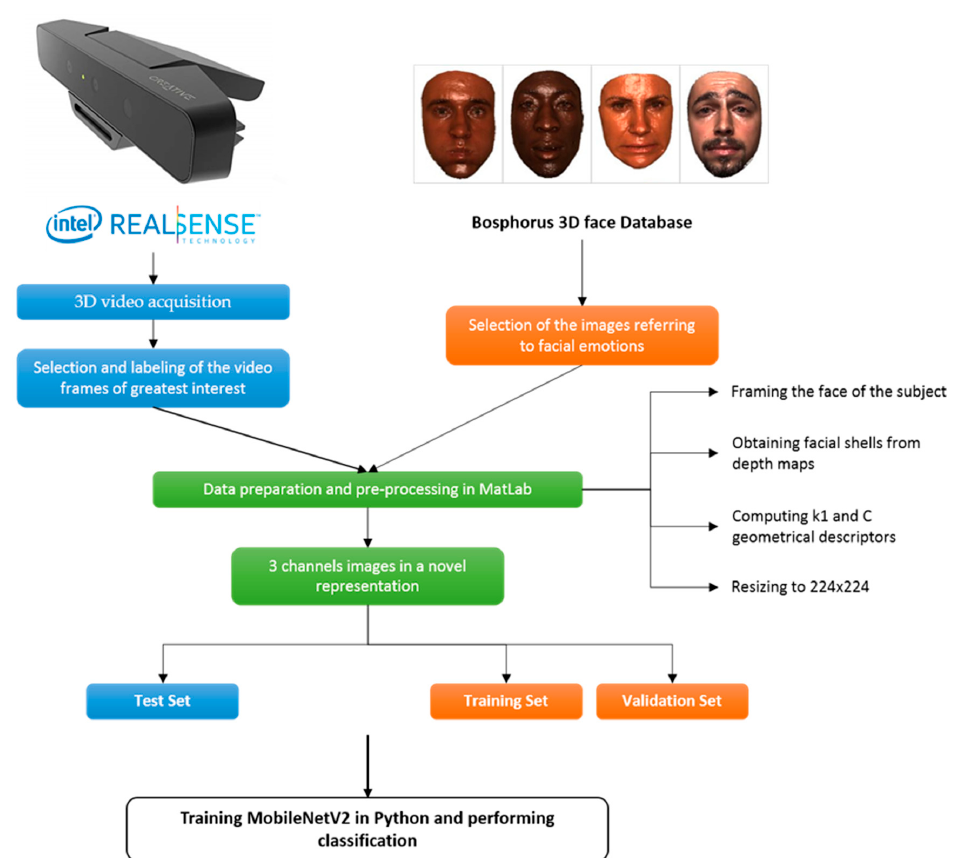
Figure 2. Scheme of the proposed methodology. Blue refers to the sensor, from acquisitions to test set, orange refers to the Bosphorus DB, and green to the common operations of data preparation and pre-processing.